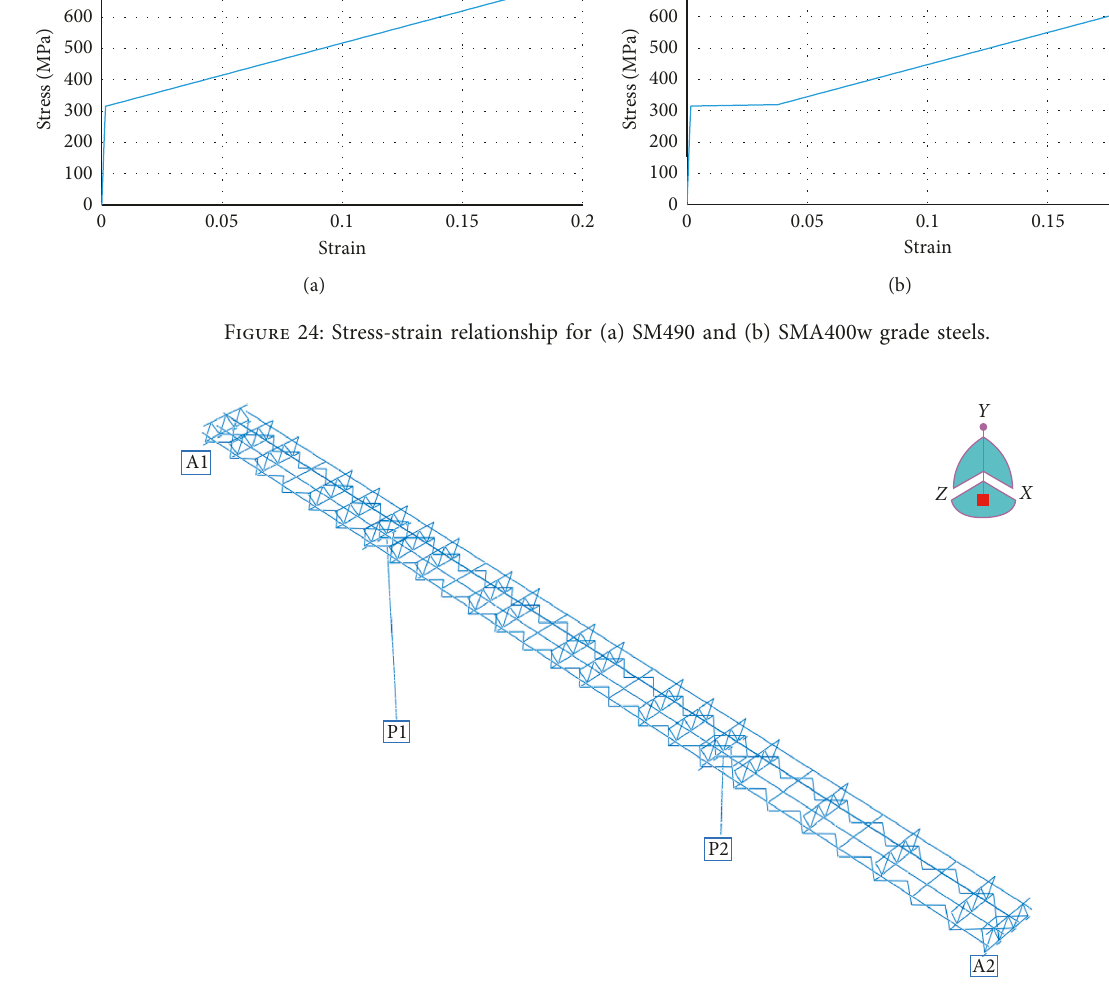
Figure 25: FE model of Tawarayama